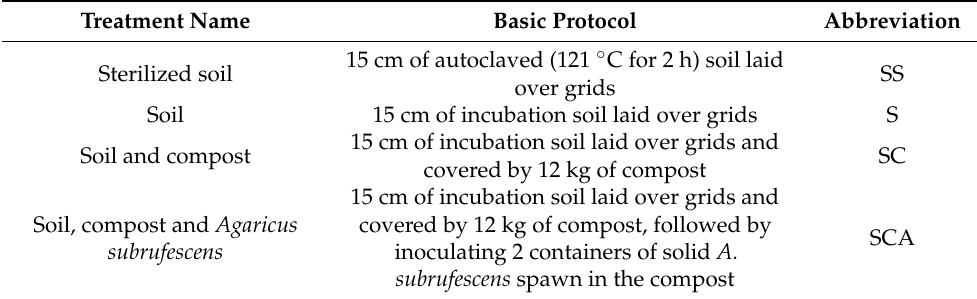
Table 1. Information of the four treatments in the glasshouse